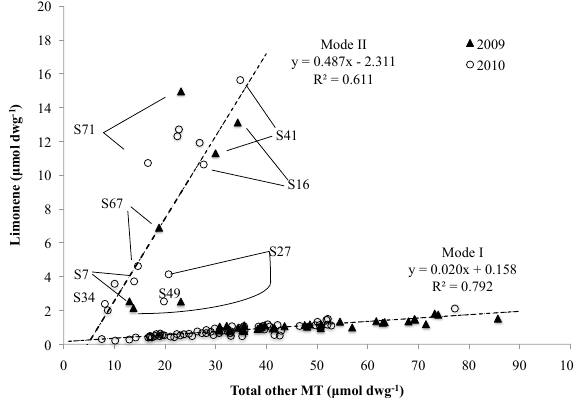
Fig. 3. The correlation between limonene and total other monoter- penes concentration at UMBS in 2009 and 2010. Data from 2008 are not included because limonene was not adequately resolved by the GC (see